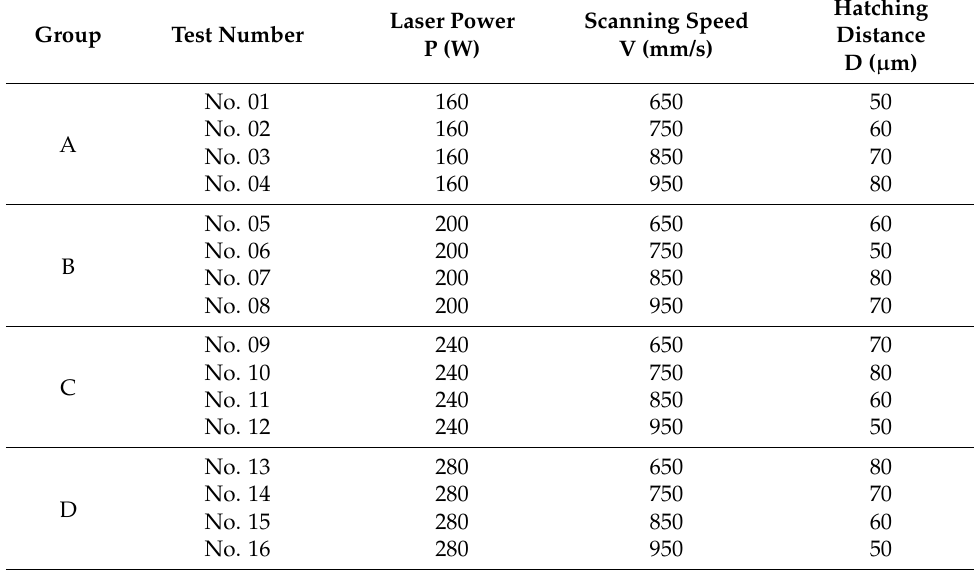
Table 2. Process parameters of alloys fabricated by